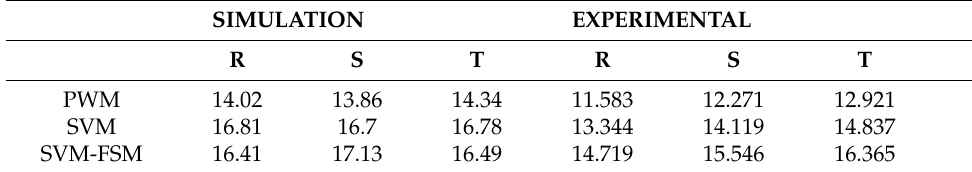
Table 6. Vrms (V), f sw = 1500 Hz.